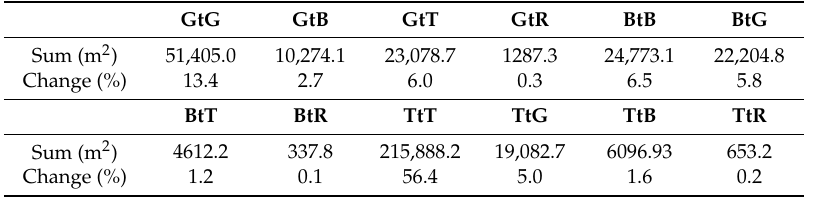
Table 5. Quantification of ‘from-to’ land-cover change. G = Grassland, B = Bare soil, T = Trees, R = Road. E.g., GtB = Grassland to Bare soil. Water and buildings have not been included.